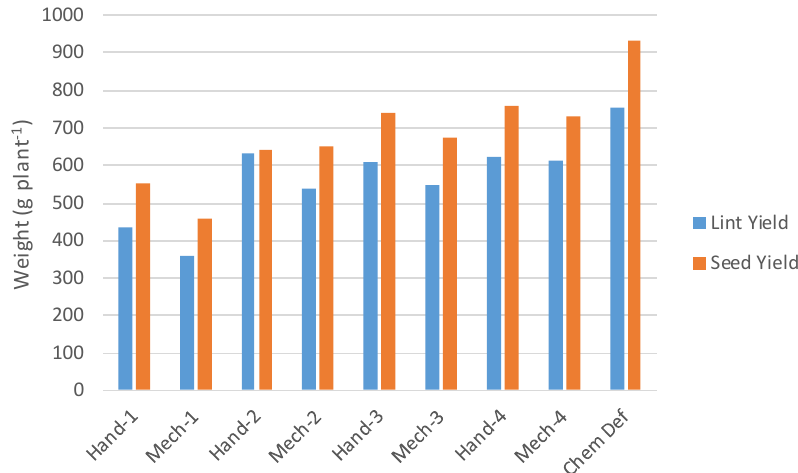
Figure 16. Yield estimation, total lint weight, for field cotton grown under commercial practices common to deficit irrigated cotton in West Texas, United States. Note: the numeral following each treatment refers to which week they were treated by girdling along with girdling method (hand knife, mechanical flap brush, chemical defoliation (control), flame girdling).